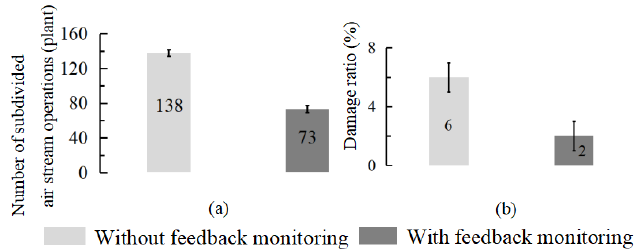
Figure 11. Response surfaces of two factors for the effective blowing rate: ( a ) Number of subdivided air stream operations. ( b ) Damage rate.